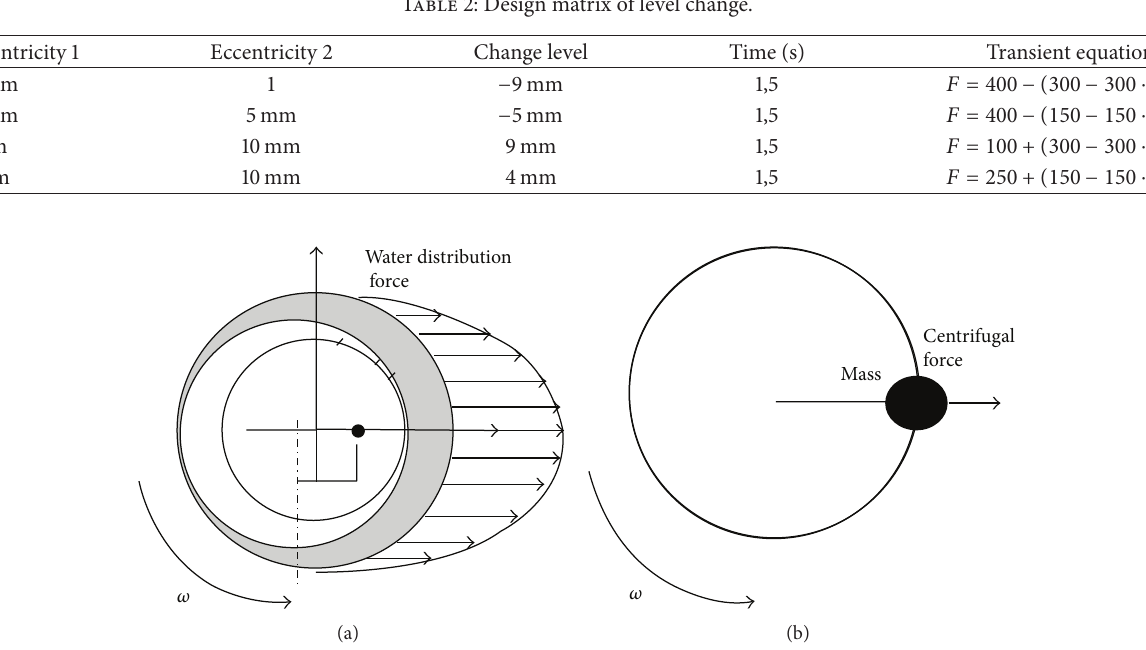
Figure 3: Schematic of restoration force simplification from distributed water force (a) and single mass centrifugal force (b).